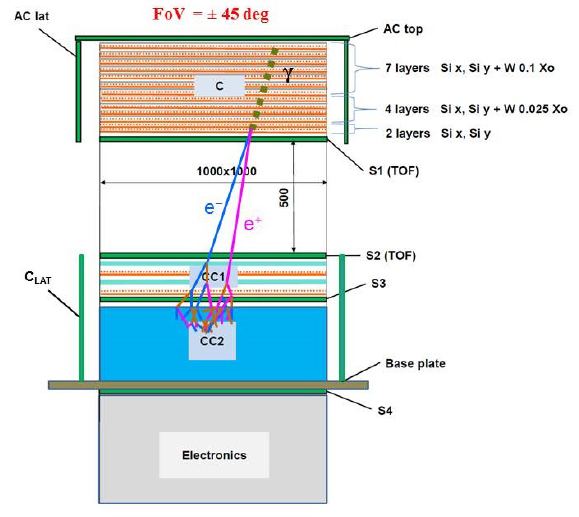
Figure 1. The GAMMA-400 physical scheme